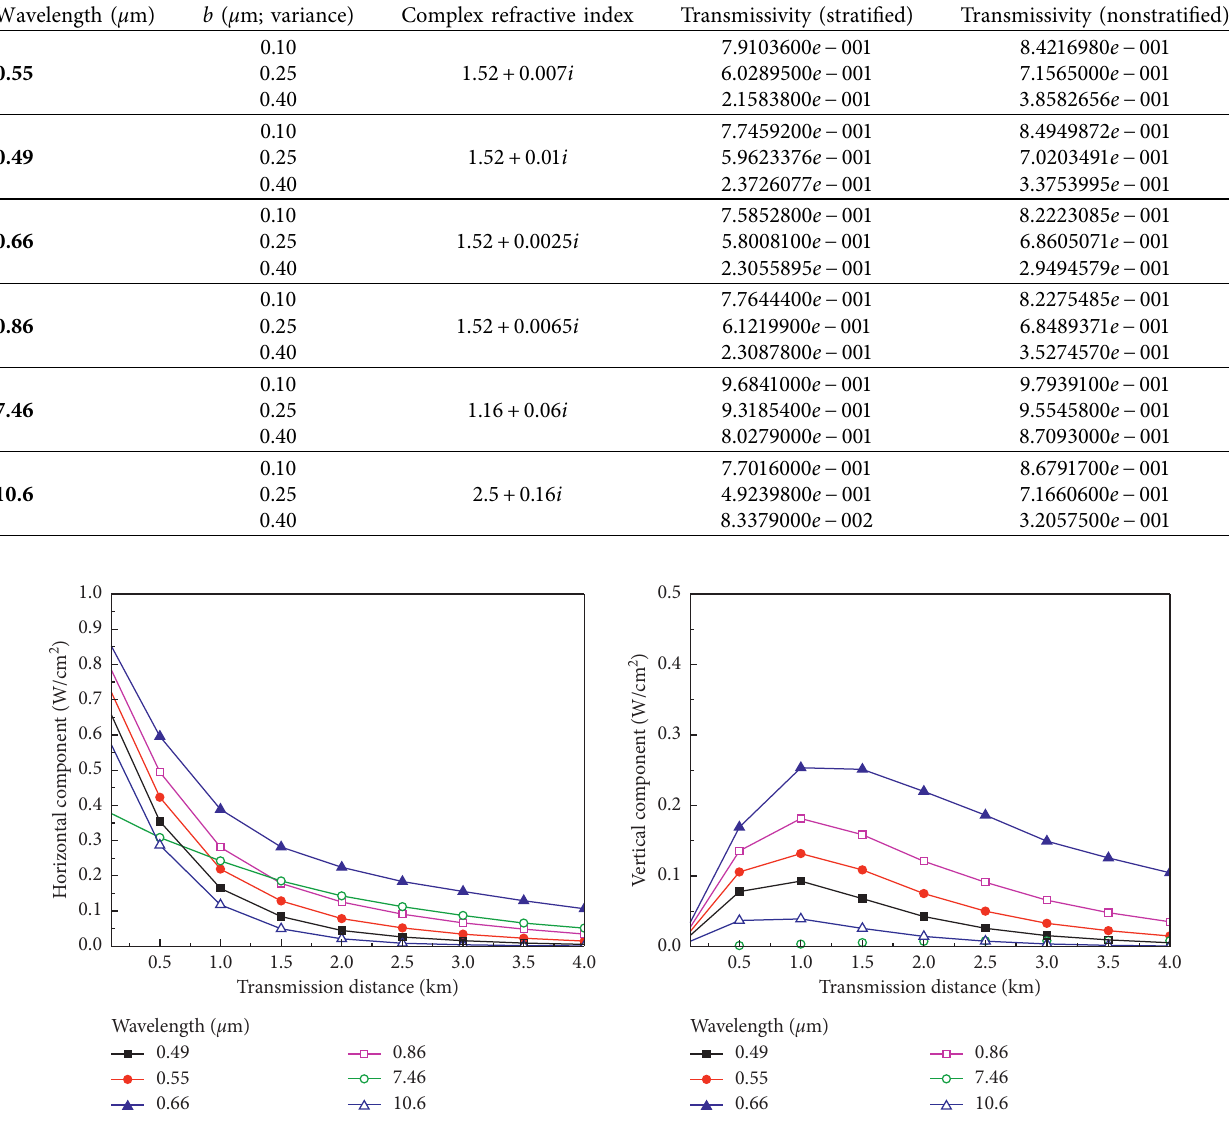
Table 3: Transmission transmittance of several typical wavelength (stratified and nonstratified). Wavelength ( μ